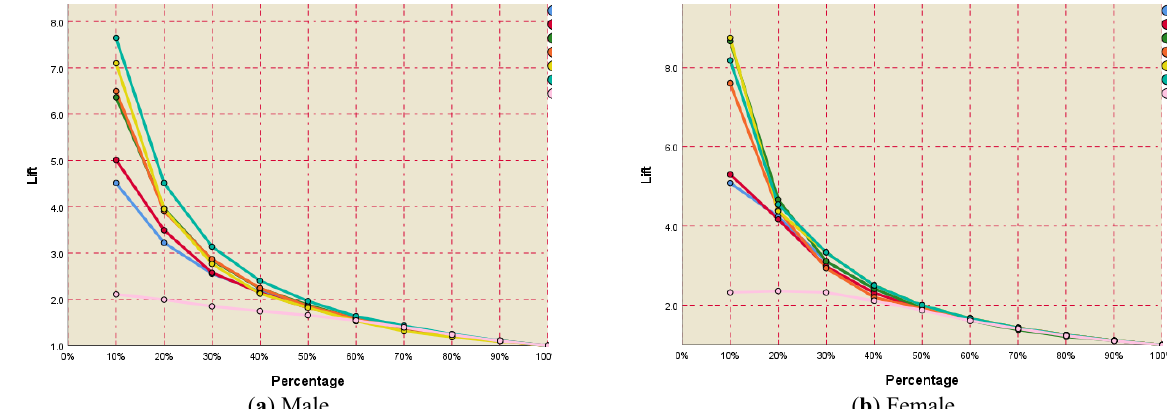
Figure 6. The lift charts for each output variable of: ( a ) male, ( b ) female. For all the variable cases, the ROC curve line is closer to the upper left corner, farther away from the 45° basslines, which depicts significantly high prediction capability, evi-